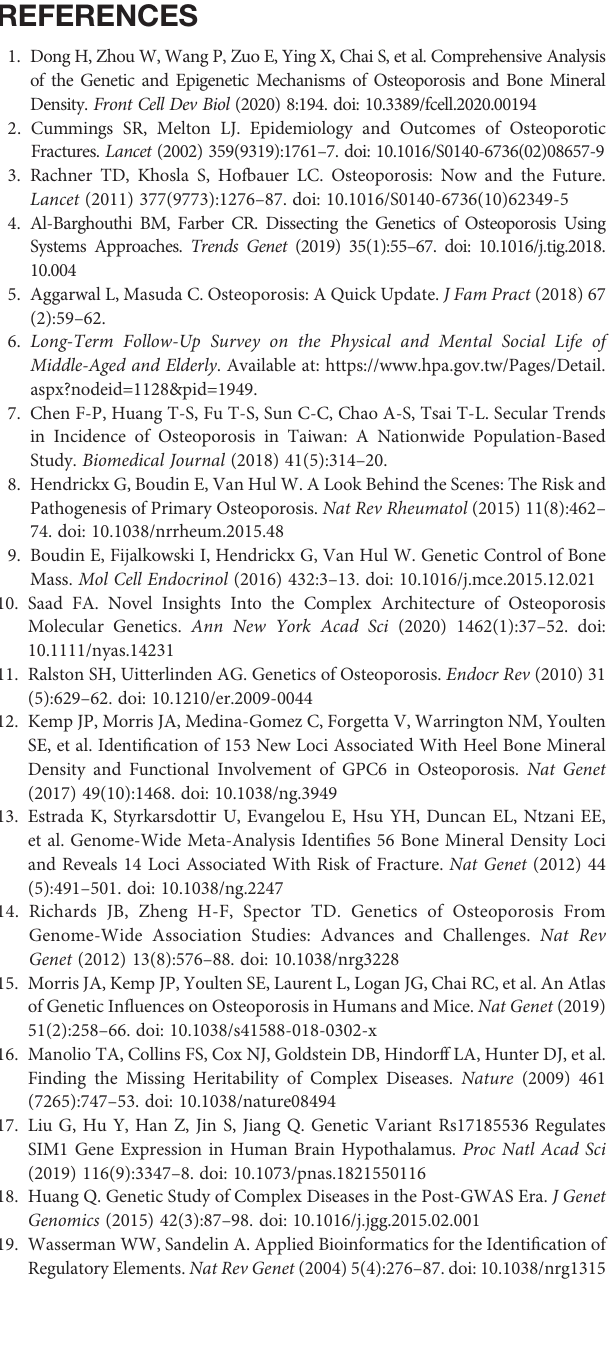
Supplementary Figure 1 | Scatter plot of RUNX2andPLCB4 expression levels in wholeblood. (A) Scatter plot ofall the expressed genes inG allele. The red line demonstrates negative correlation between RUNX2and PLCB4 with Pearson ’ s correlationcoef fi cientof0.283. (B)